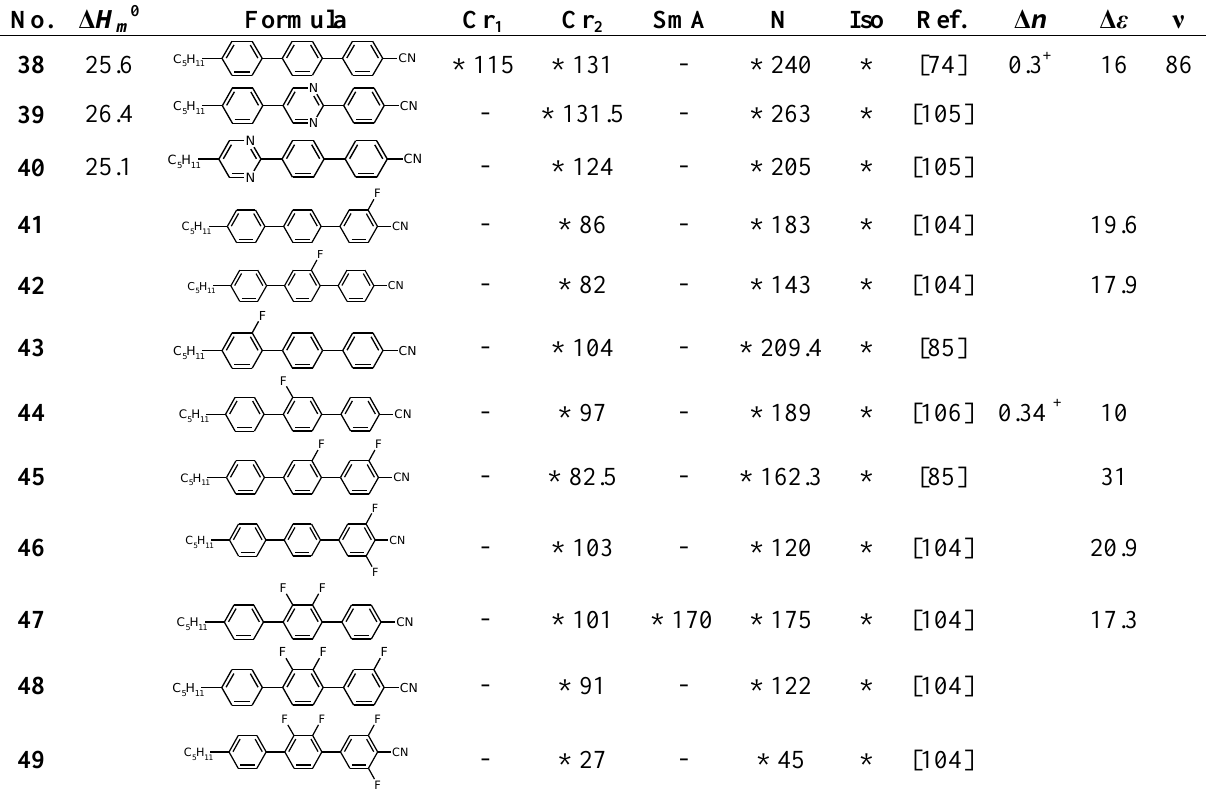
Table 8. Phase transitions temperatures [°C], melting enthalpies [kJ/mol], birefringence, bulk viscosity [mPa∙s] and dielectric anisotropy of alkyl cyanoterphenyls.